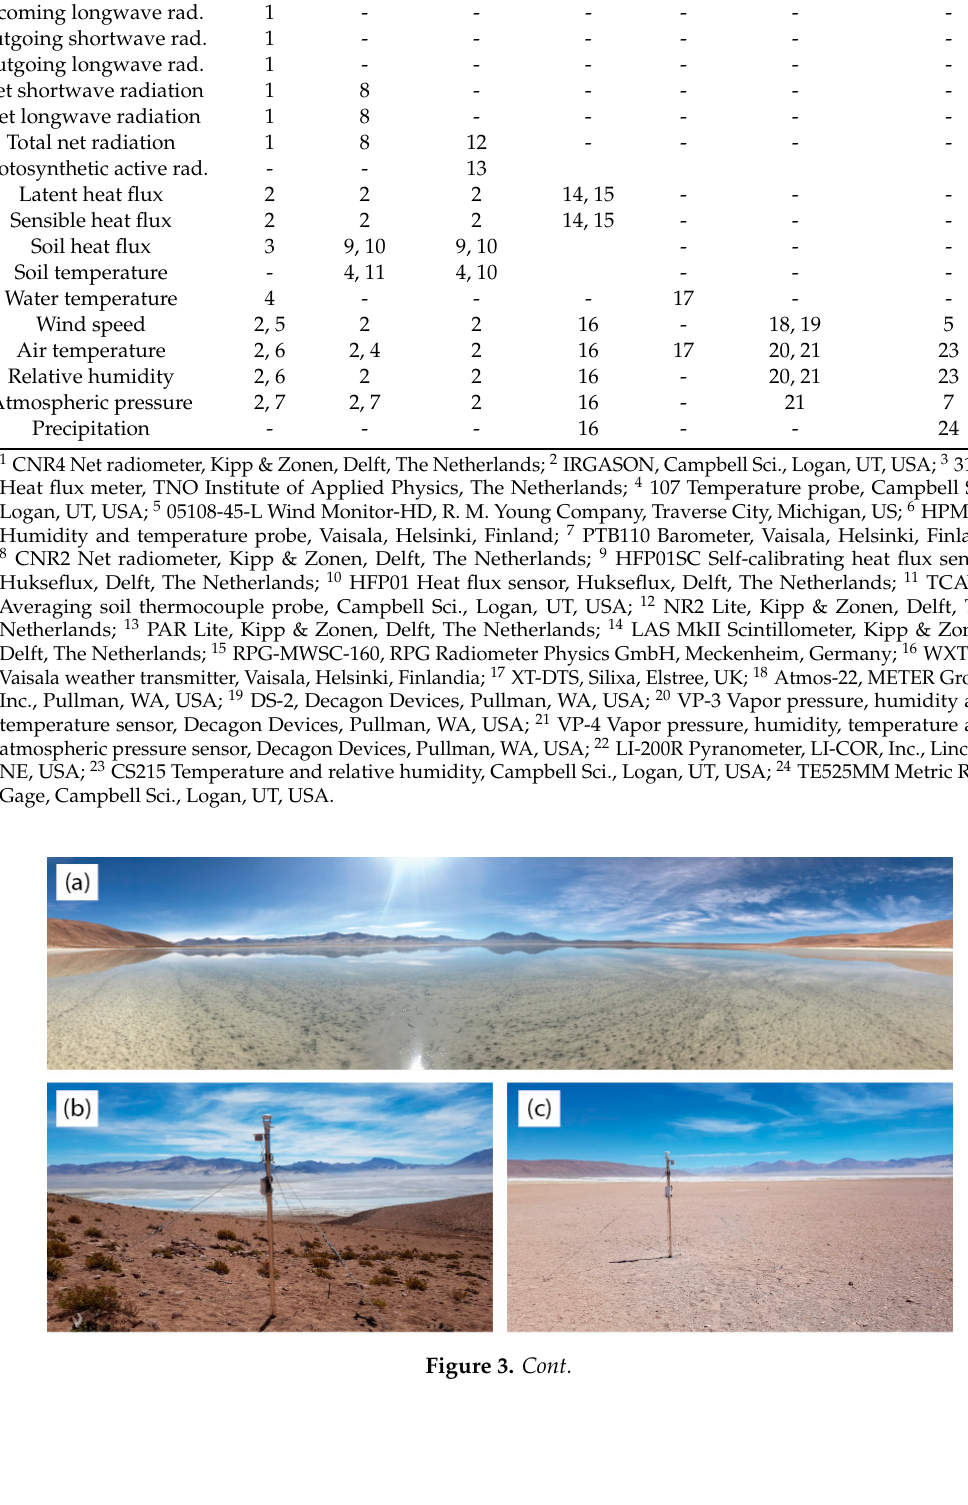
Incoming shortwave rad. Outgoing shortwave rad.